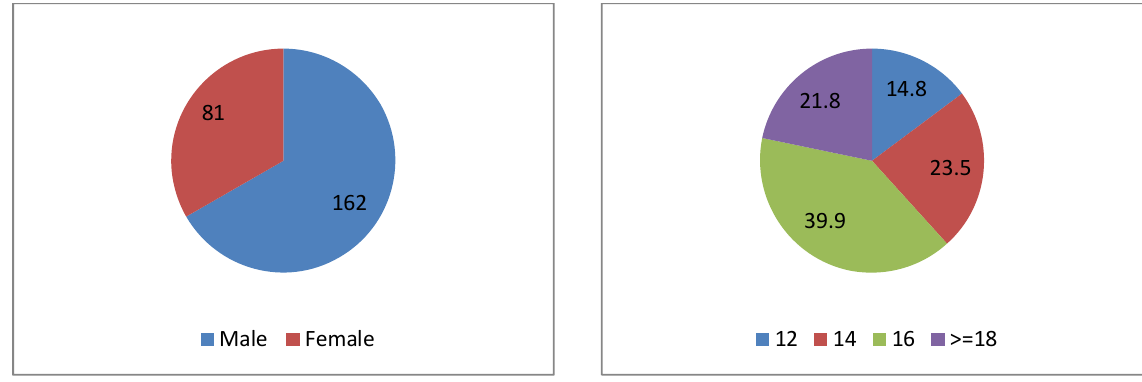
Fig. 1. Personal charactersitics of the